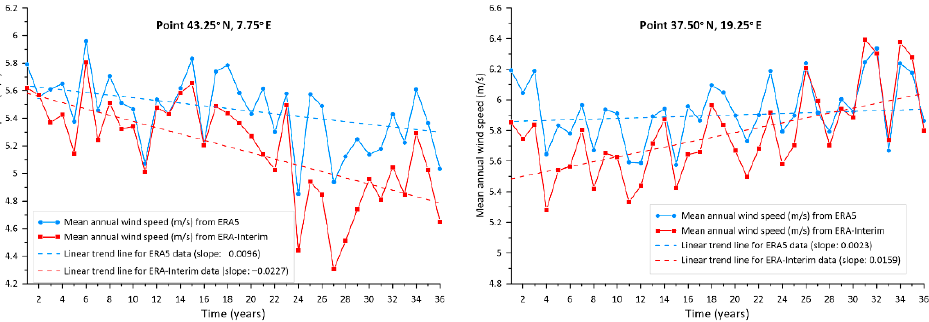
Figure 9. Linear slope of the mean annual wind speed for the locations 43.25° N, 7.75° E ( left ) and 37.50° N, 19.25° E ( right ), as obtained from the ERA-Interim and ERA5 datasets.